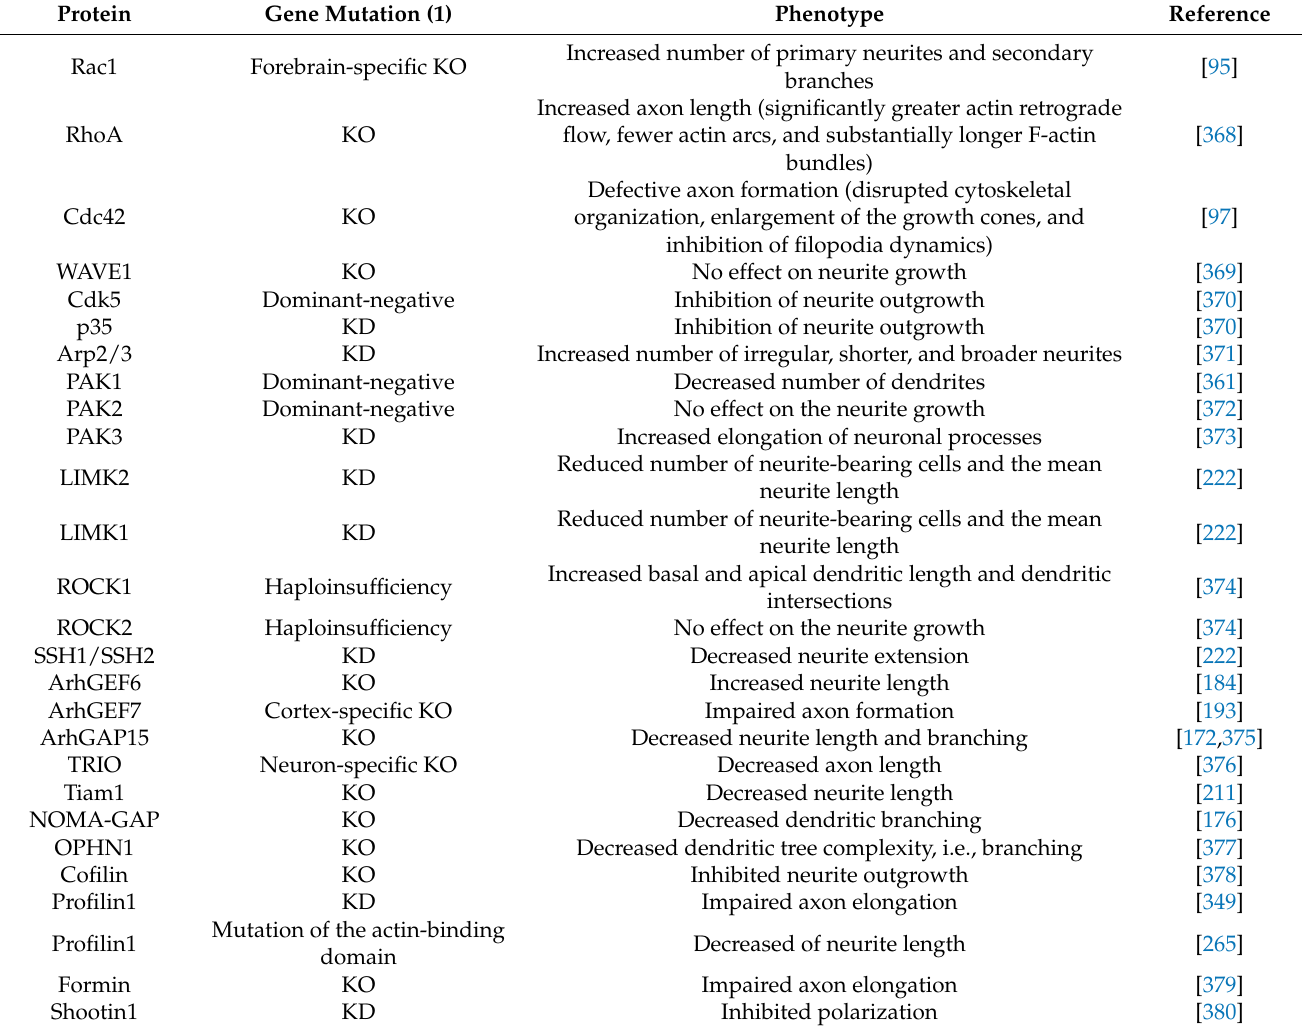
Table 2. Proteins involved in the regulation of neurite elongation with the corresponding KO/KD phenotypes. Protein Gene Mutation (1) Phenotype Reference Increased number of primary neurites and secondary Rac1 Forebrain-specific KO branches Increased axon length (significantly greater actin retrograde KO flow, fewer actin arcs, and substantially longer F-actin